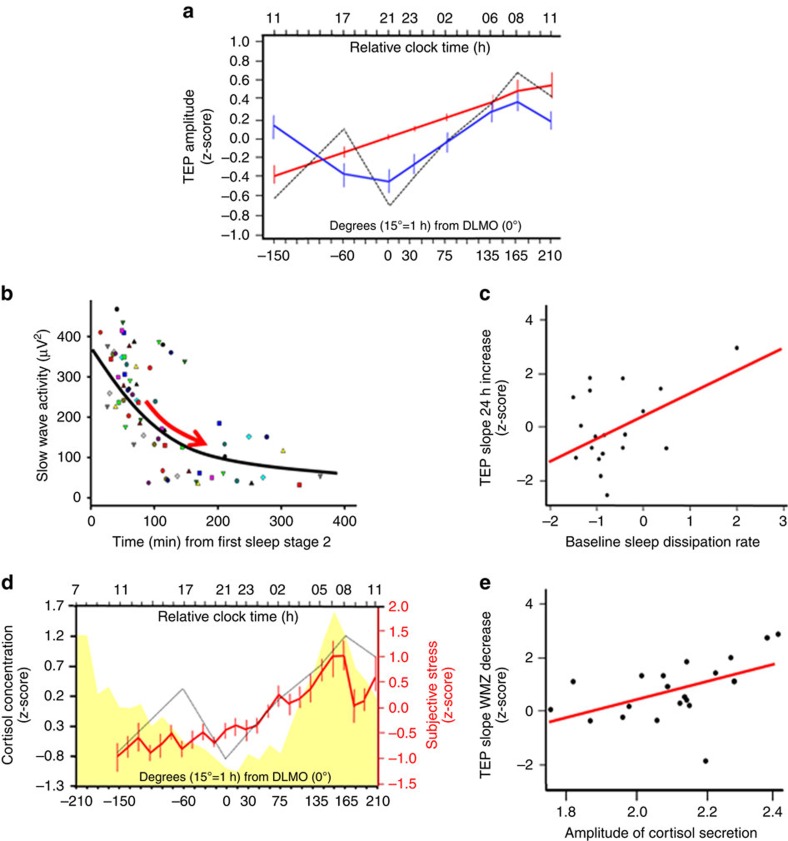
The circadian system modulates cortical excitability.(a) Individual cortical excitability measured by TEP amplitude (dashed line represents average z-scored TEP amplitude) was fitted with linear (red) and 24 h period sine-wave (blue) functions to mimic sleep pressure build-up and the circadian signal respectively. Error sum of squares (ESS) was <10 for both indices (amplitude: ESS linear fit=4.9, P<0.0001; ESS sine fit= 4.1, P<0.0001; slope: ESS linear fit=5.19, P<0.0001; ESS sine fit=4.24, P<0.0001). (b) Slow wave activity across the first four cycles of sleep baseline night was fitted to compute individual dissipation rate (schematically shown by red arrow). Each dot represents SWA of an individual sleep cycle (four identical symbols per participant). (c) Regression analysis showed that individual dissipation rate was positively correlated with the increase in cortical excitability from first to last session, recorded 24 h apart, at the same circadian phase, following a normal night of sleep and after sleep deprivation (n=18; amplitude: P=0.044; r2=.23; slope: P=0.036, r2=0.25). (d) Cortisol (yellow) and subjective stress (red) levels. Salivary cortisol concentration was not significantly different between the first and the last protocol samples, collected 24 h apart, at the same circadian phase, following a normal night of sleep and after sleep deprivation (n=22; F(28,482)=13.44; P<0.0001). Dashed line: shape of TEP z-scored amplitude dynamics. (e) Regression analysis revealed that individual fitted amplitude of cortisol secretion over the protocol was positively associated with the decrease in cortical excitability measured around the wake-maintenance zone (n=20; amplitude: P=0.017; r2=0.24; slope: P=0.023, r2=0.21).